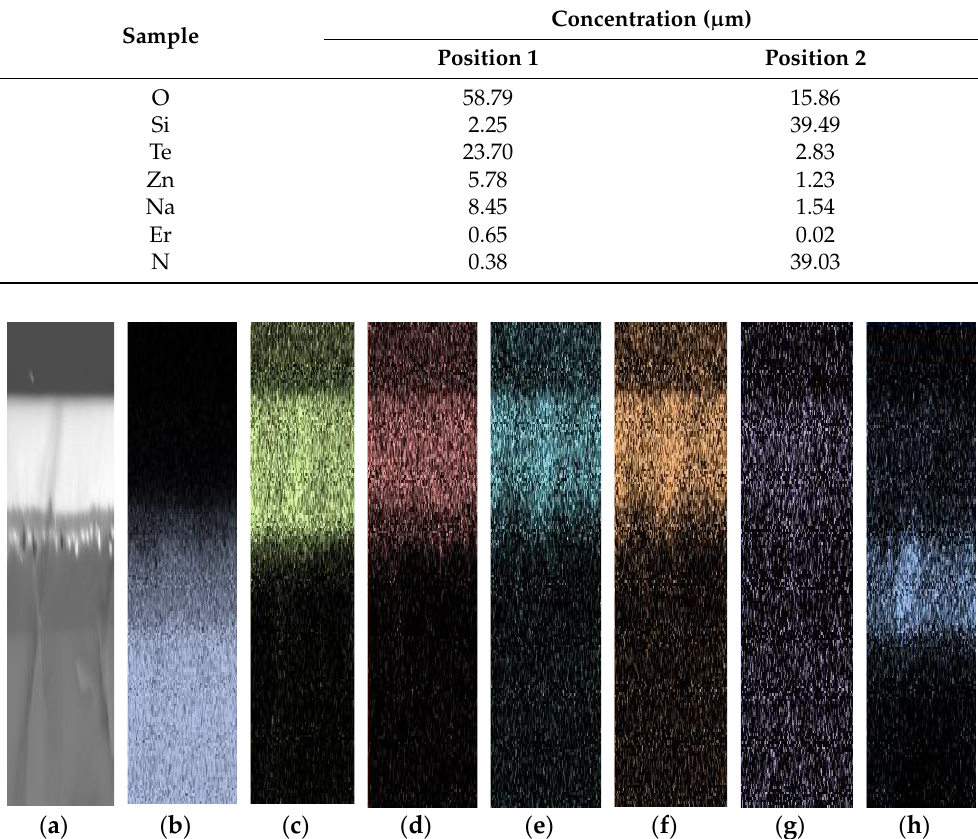
Figure 11. Area scan measured by EDX-SEM for sample K470 with ( a ) the area being measured. The distribution of species presented is that of ( b ) silicon, ( c ) oxygen, ( d ) tellurium, ( e ) sodium, ( f ) zinc, ( g ) erbium, and ( h ) nitrogen.